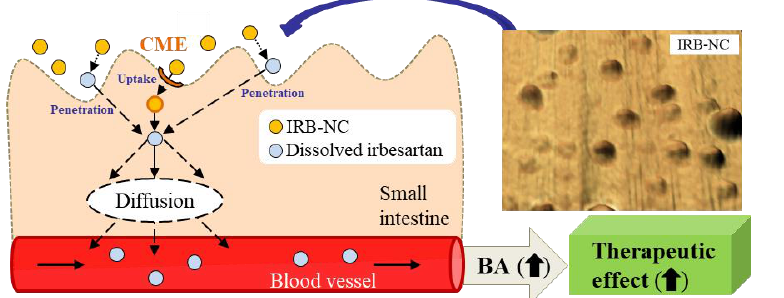
Figure 7. Mechanism of the intestinal penetration pathway and the hypertension preventive effect following the oral administration of IRB-NC suspensions.